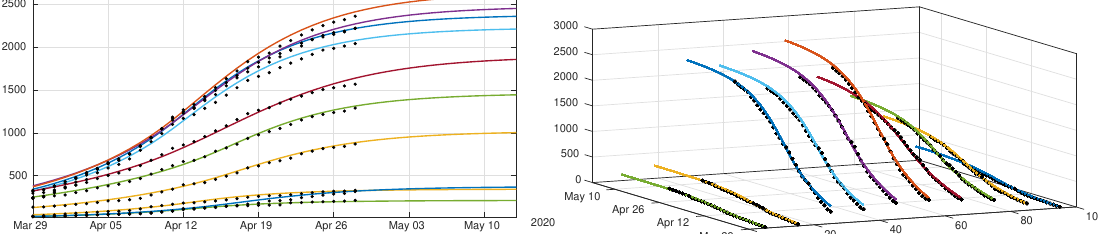
Figure 11. We plot a comparison between the model (12)–(15) and the age structured data from Japan by age class. We took 1/ ν = 1/ η = 7 days for each age class. Our best fit is obtained for f i which depends linearly on the age class until it reaches 90%, with f 1 = 0.1, f 2 = 0.2, f 3 = 0.3, f 4 = 0.4, f 5 = 0.5, f 6 = 0.6, f 7 = 0.7, f 8 = 0.8, f 9 = 0.9, and f 10 = 0.9. The values we used for the first day of public intervention are D i = 13 April for the 0–20 years age class i = 1,2, D i = 11 April for the age class going from [ 20,30 [ to [ 60,70 [ i = 3,4,5,6,7, and D i = 16 April for the remaining age classes. We fit the data from 30 March to 20 April to derive the value of χ i and χ i for each age class. For the 2 1 intensity of confinement we use the values µ 1 = µ 2 = 0.4829, µ 3 = µ 4 = 0.2046, µ 5 = µ 6 = 0.1474, µ 7 = 0.0744, µ 8 = 0.1736, µ 9 = µ 10 = 0.1358. By applying the method described in Appendix A, we obtain τ 1 = 0.1630, τ 2 = 0.1224, τ 3 = 0.3028, τ 4 = 0.2250, τ 5 = 0.1520, τ 6 = 0.1754, τ 7 = 0.1289,